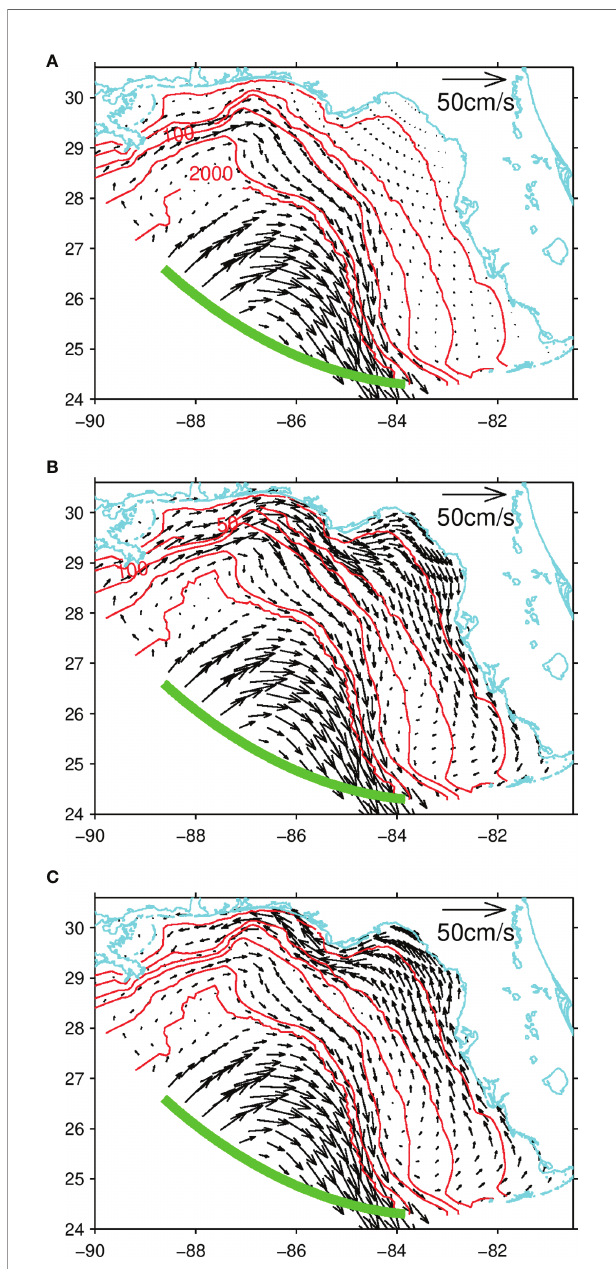
FIGURE 7 | Simulated WFS responses to Loop Current forcing alone (A) ; Loop Current, plus upwelling favorable wind forcing (B) ; and Loop Current, plus downwelling favorable wind forcing (C) . The green line denotes the region of Loop Current in fl ow and out fl ow (from He and Weisberg, 2003). The vectors are depth averaged currents, and the (red) depth contours are the 20 m, 50 m, 100 m, 200 m, 1000 m and 2000 m